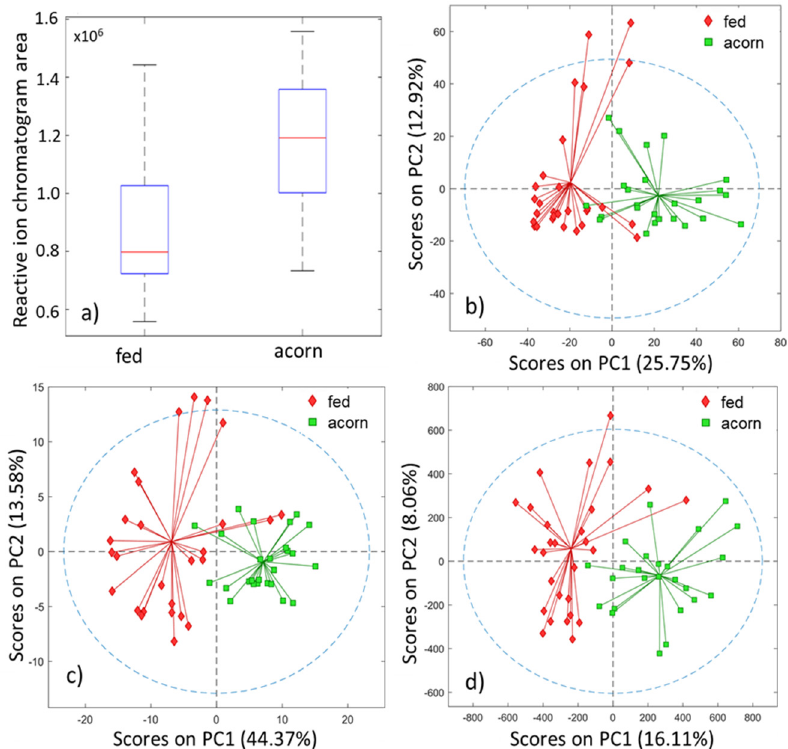
Figure 4. Unsupervised exploration of the four extraction methods: ( a ) boxplot for the RIC area, PCA scores plots for ( b ) reactive ion chromatogram, ( c ) full matrix, ( d ) peak table.